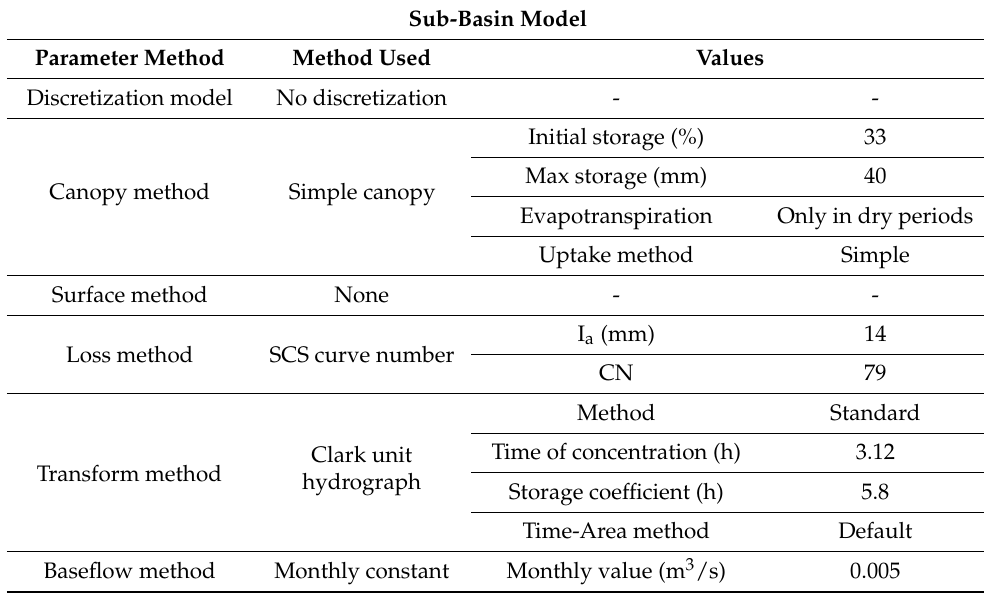
Table 4. HEC-HMS methods used in the study and their